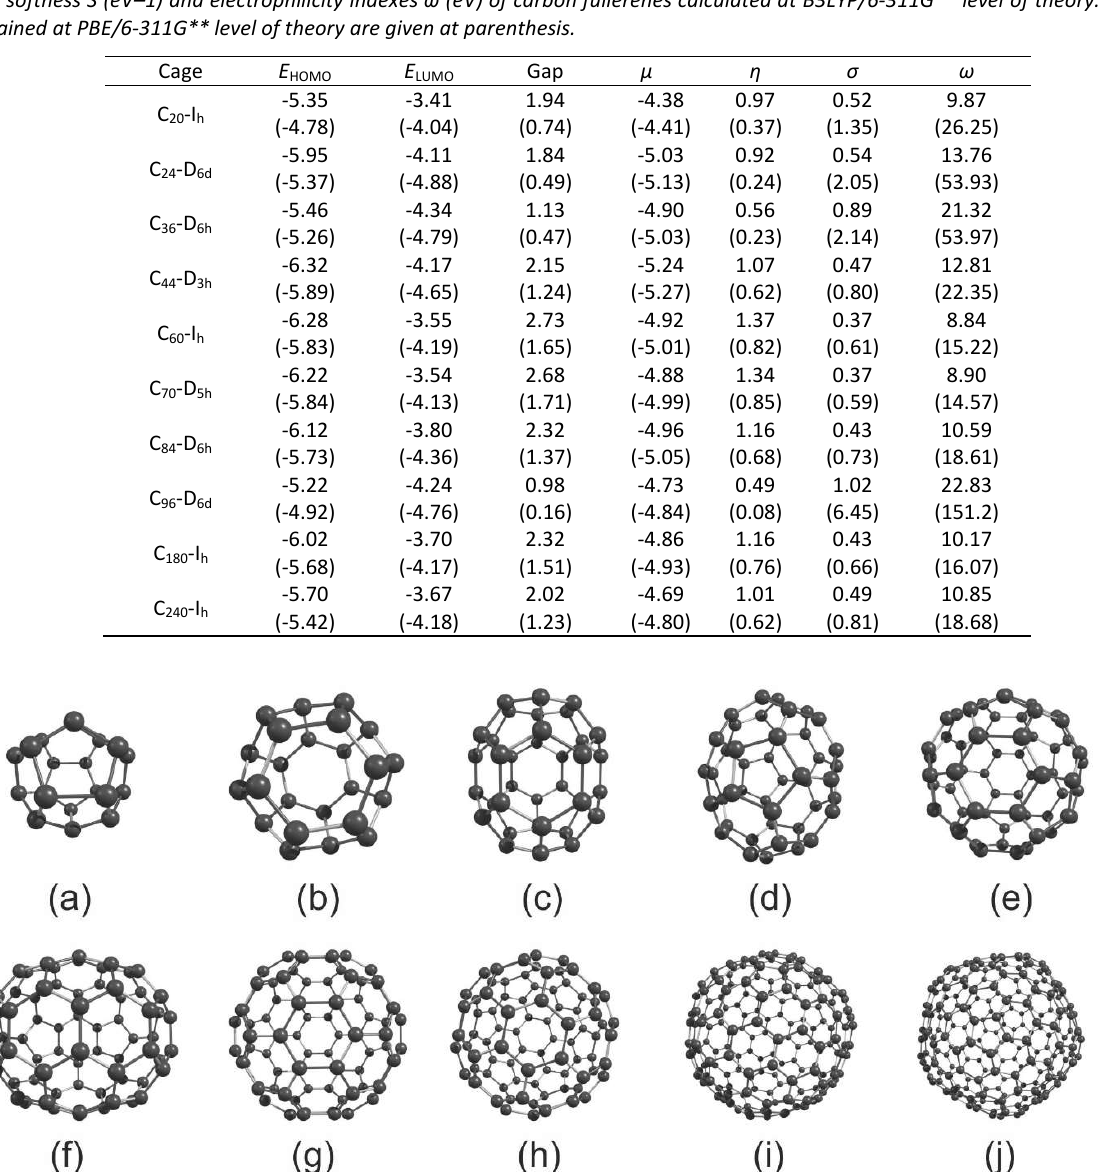
Fig.1. Optimized structures of the studied carbon fullerenes, [C 20 , C 24 , C 36 , C 44 , C 60 , C 70 , C 84 , C 96 , C 180 , C 240 ,